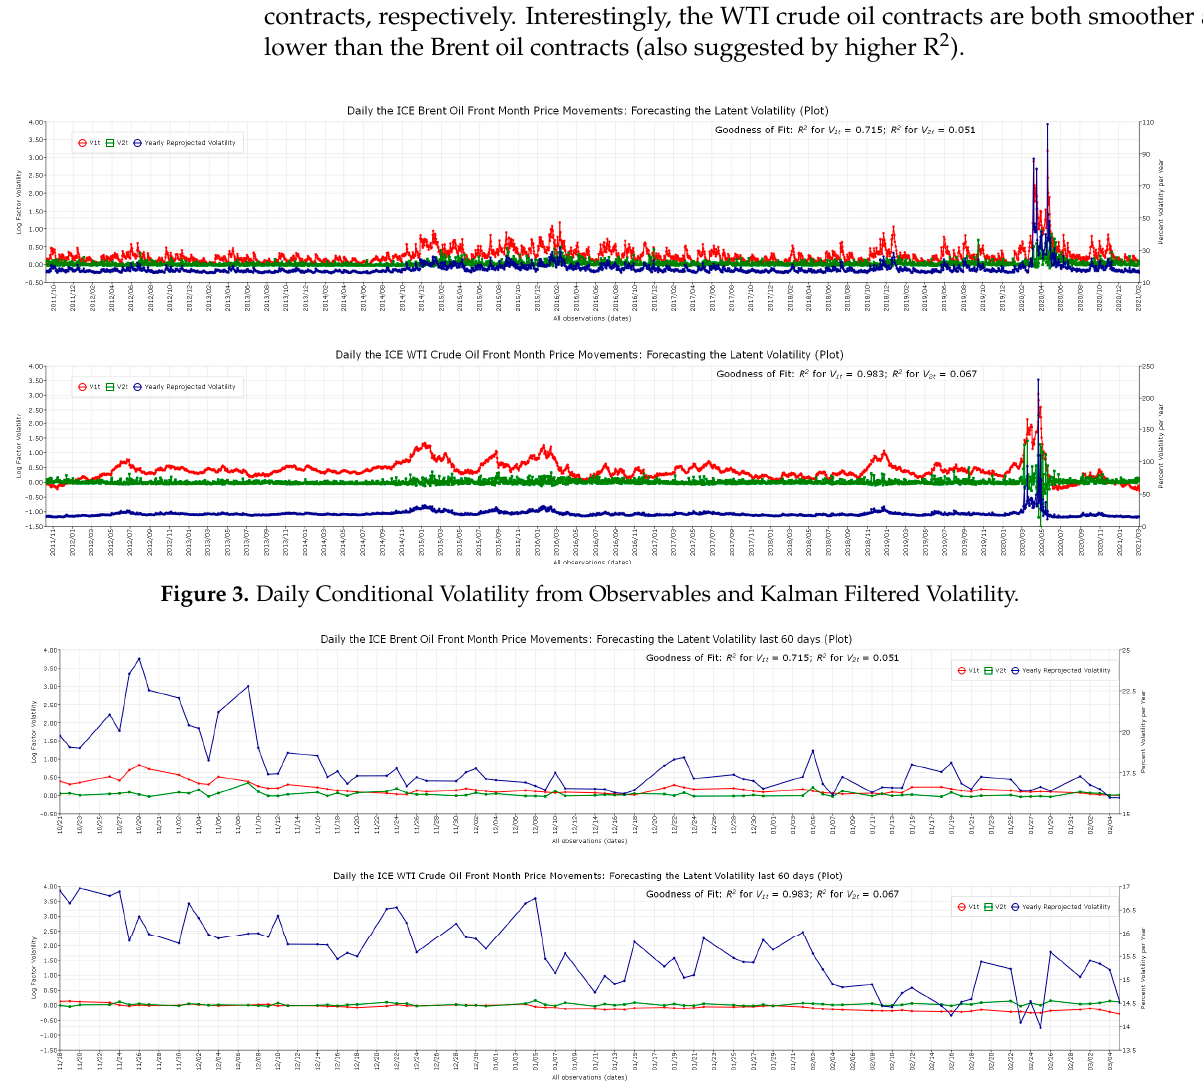
Figure 4 . The ICE Front Month Brent Oil ( top ) and WTI Crude Oil ( bottom ) Factor Volatility Paths (last 60 days) .